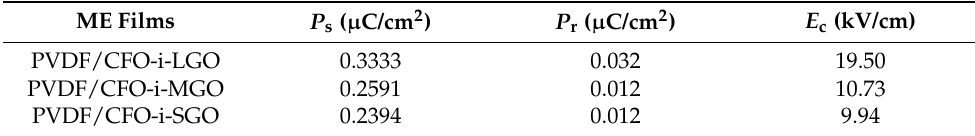
Table 4. Electrical properties in the 3-2 type ME films of PVDF/CFO-i-LGO, PVDF/CFO-i-MGO, and PVDF/CFO-i-SGO.